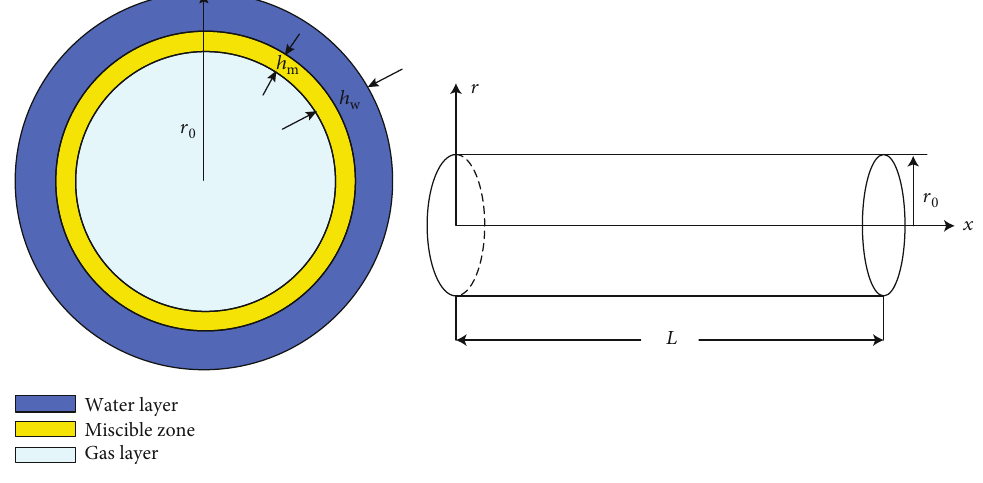
Figure 3: Schematic view of the